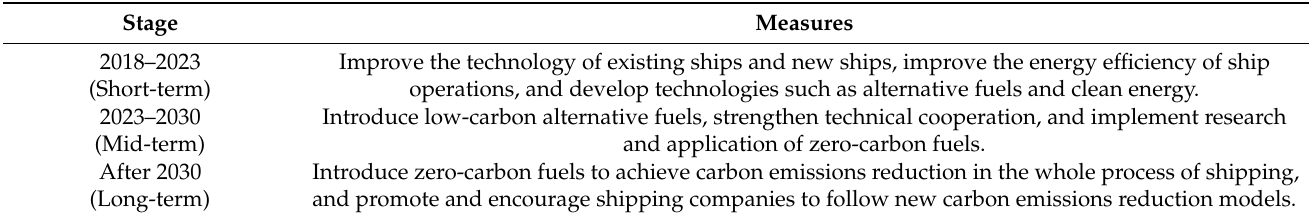
Table 1. Three stages of IMO carbon emissions reduction and its